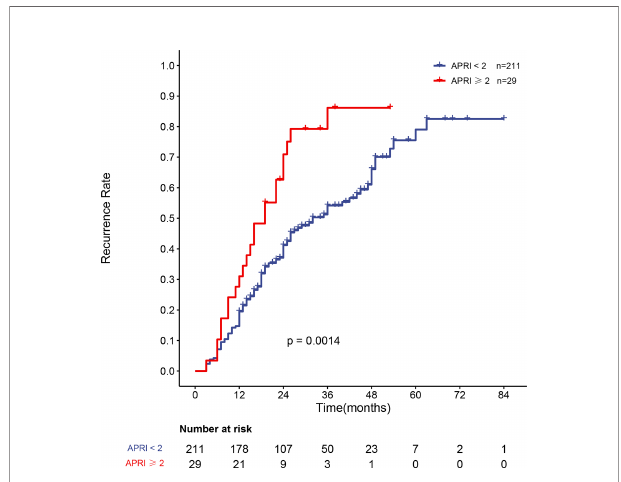
FIGURE 4 | Curve of the recurrence rate of 240 HBV-related sHCC patients with an APRI <2 and an APRI ≥ 2. HBV, hepatitis B virus; sHCC, small hepatocellular carcinoma; APRI, aspartate aminotransferase-to- platelet ratio